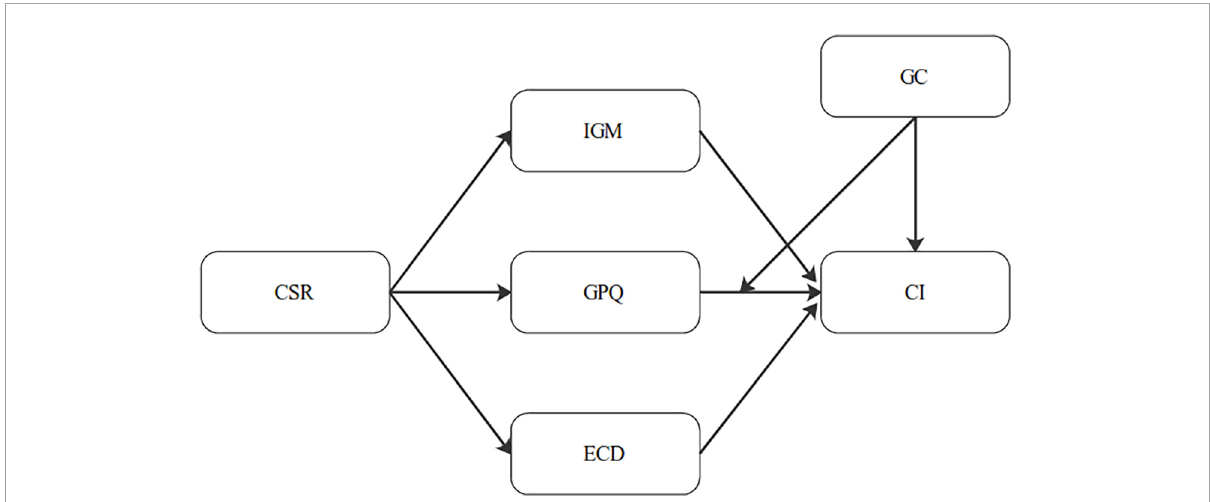
FIGURE1 Conceptual framework. CSR, corporate social responsibility; IGM, internal green management; ECD, eco-design; GPQ, green perceived quality; GC, green concern; CI, customer intention.